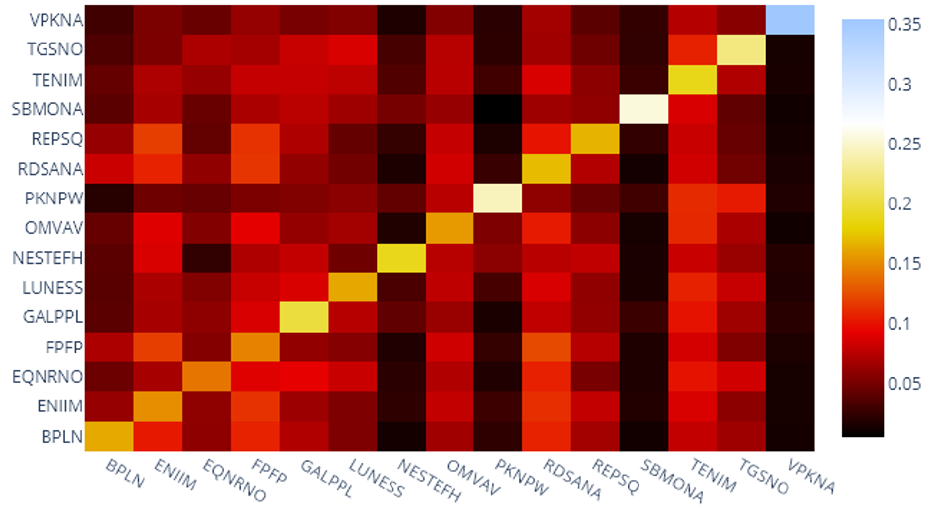
Figure 1. Spillovers across companies inside the energy sector for CoVaR measures — full sample.